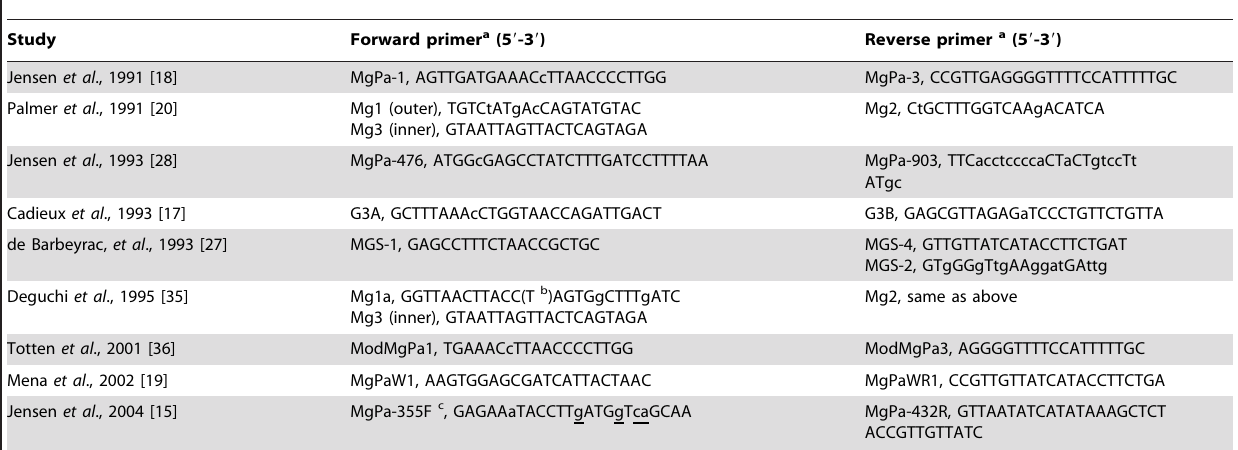
Table 3. Sequence variation in published PCR primers targeting the MgPa